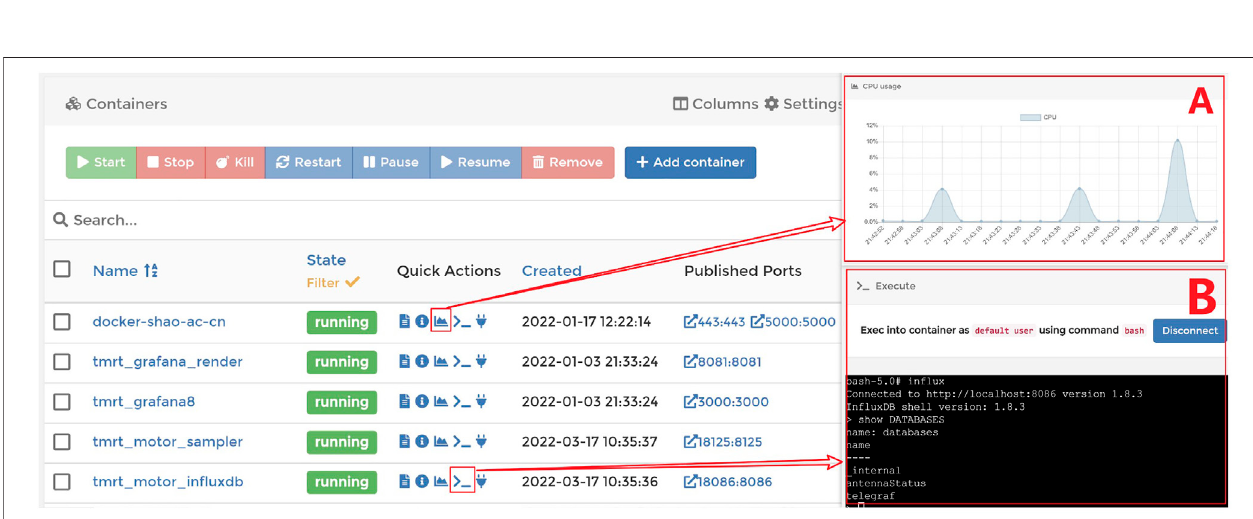
Frontiers in Astronomy and Space Sciences |